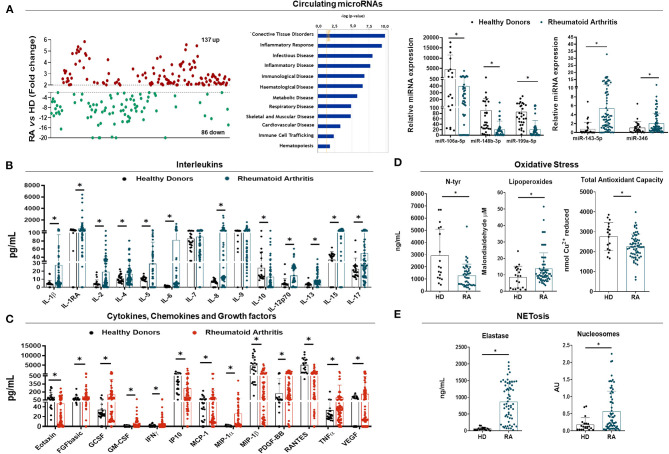
Molecular characterization of rheumatoid arthritis patients. (A) Whole circulating microRNA (miRNA) expression profile in plasma of Rheumatoid Arthritis (RA) patients (n = 6) and healthy donors (HDs) (n = 3) by HTG EdgeSeq Assay showing miRNAs up-regulated in red and miRNAs downregulated in green (Fold Change >2 or <-2) (Left panel). Functional classification of altered miRNAs according biological functions and diseases following Ingenuity Pathway Analysis (central panel). RT-PCR validation of selected miRNAs associated with the pathogenesis of RA (right panel). (B) Interleukin profile of RA patients and HDs in serum by Luminex Assay (Bio-Plex). (C) Cytokine, chemokine and growth factor profile of RA patients and HDs in serum by Luminex Assay (Bio-Plex). (D) Oxidative stress markers in serum of RA patients and HDs including Nitrotyrosine (N-Tyr), Lipoperoxides and Total Antioxidant Capacity (TAC). (E) NETosis-derived products in serum of RA patients and HDs including neutrophil elastase and nucleosome levels. Analyses were performed on the whole cohort of RA patients (n = 79) and HD (n = 29). *p < 0.05.